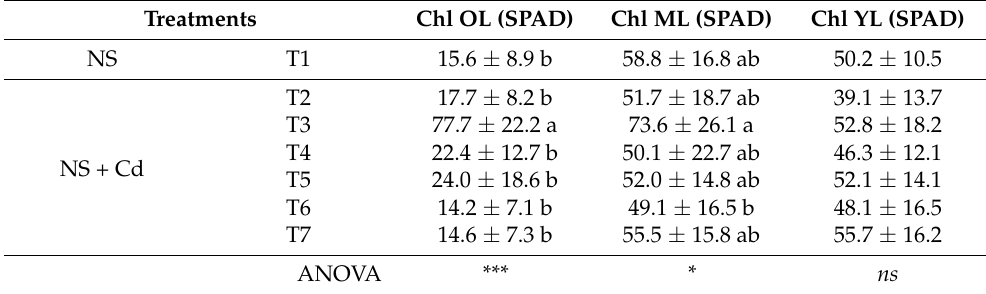
Table 3. Relative chlorophylls content measured in old leaves (OL), middle-aged leaves (ML), and young leaves (YL) of broccoli plants grown under Cd toxicity conditions and treated with different active materials to mitigate this toxicity (T1: NS, T2: NS + Cd, T3: NS + Cd + BioG, T4: NS + Cd + Se1,